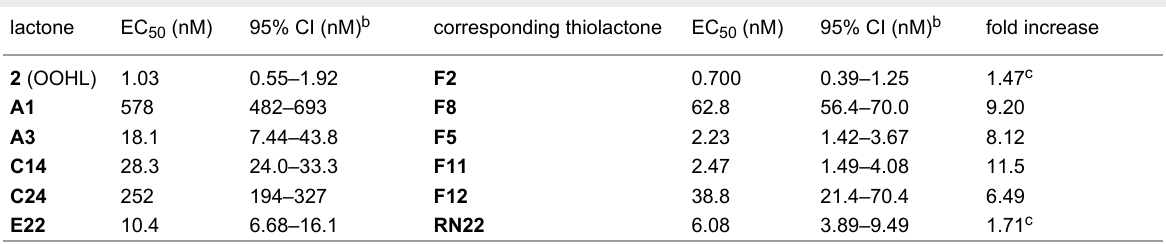
Table 2: Comparison of selected lactone and thiolactone analog EC 50 values in SdiA. a lactone